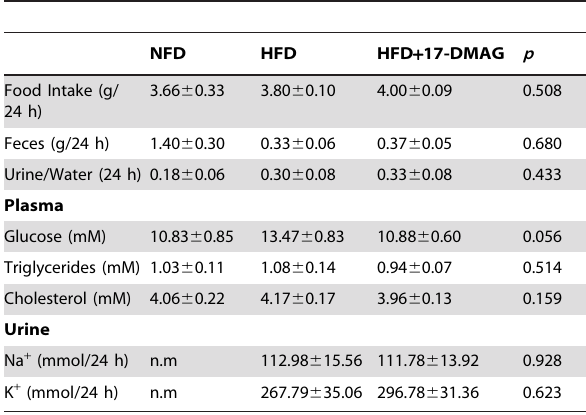
Table 1. Effects of GA treatment on physiological parameters of mice fed with